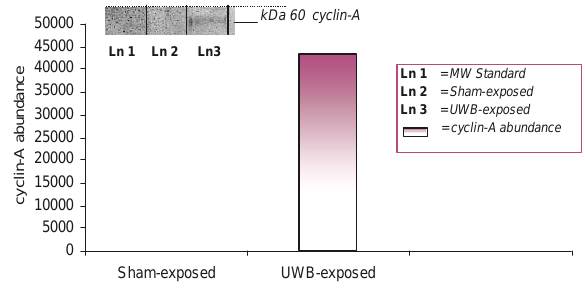
Figure 5: Western blot for cyclin-A expression and densitometric analysis in UWBR-treated AML-12 mouse hepatocytes. AML-12 mouse hepatocytes were exposed to UWB pulses for 2 h at a temp of 23 o C, pulse width of 10 ns, repetition rate of 1 kHz, and applied field strength of 5-20